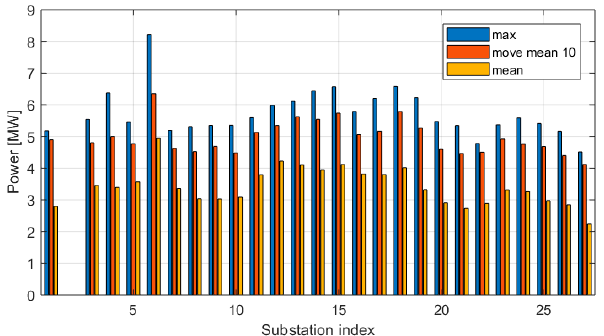
Figure 12. Traction power of substations.